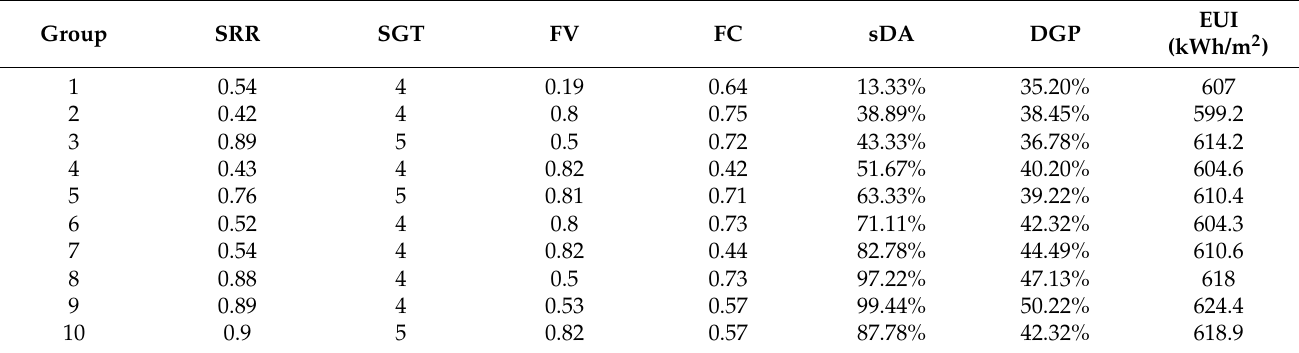
Figure 22. Pareto frontier images of fabric shading commercial atrium. Table 15. Fabric shading commercial atrium pareto-front solution